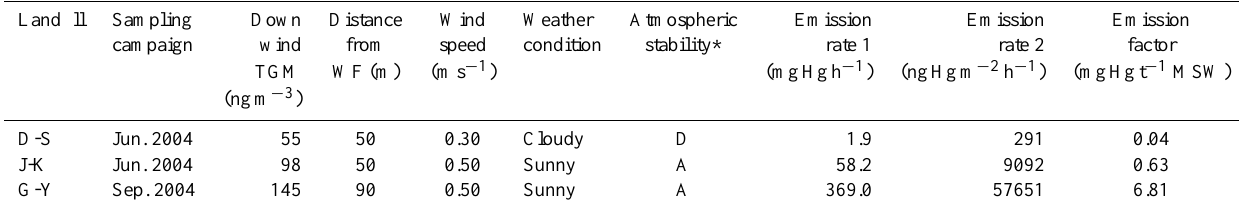
Table 4. Hg emission rate from the working face of 3 operational landfills calculated by ISCST3 model.